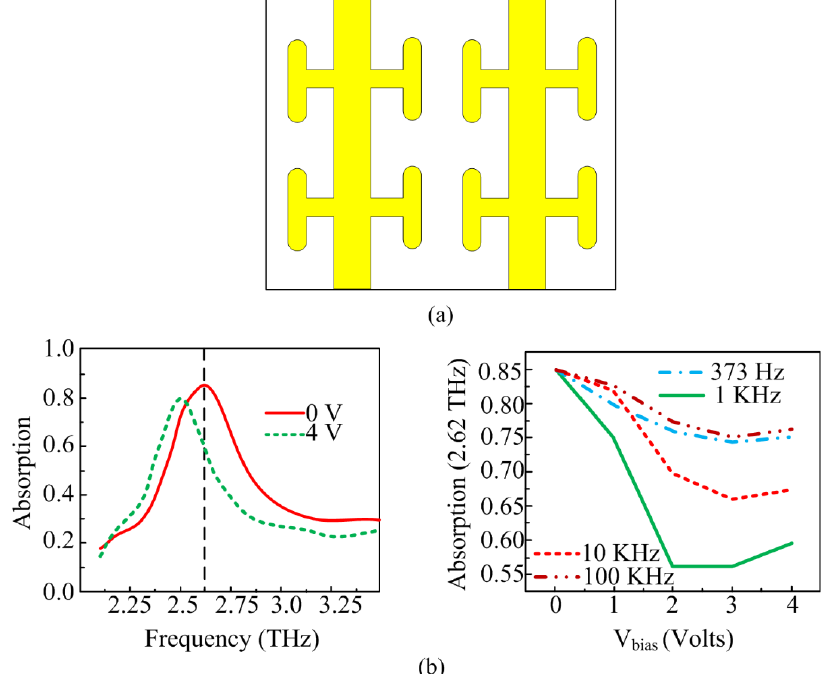
Figure 17. ( a ) Unit cell geometry of reported liquid crystal-based metamaterial absorber. ( b ) Ab- sorption percentage of reported absorber in which liquid crystals are either aligned or not (adapted from [172]).